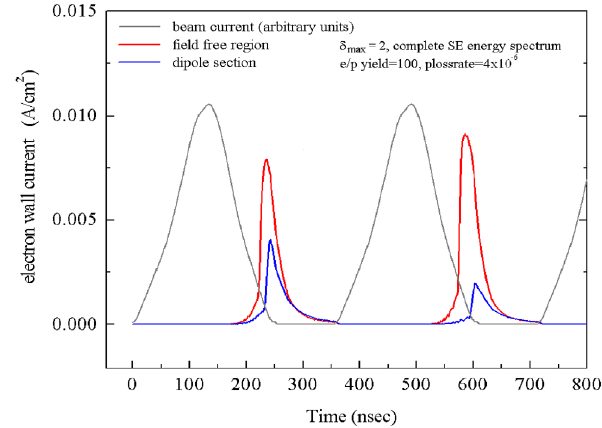
FIG. 7. (Color) Simulated current of electrons hitting the sur- face of the vacuum chamber during the first bunch passages, in a PSR field-free region and a dipole section.